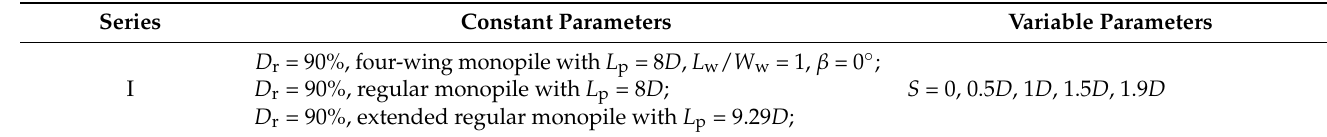
Table 2. Numerical simulation cases for parametric